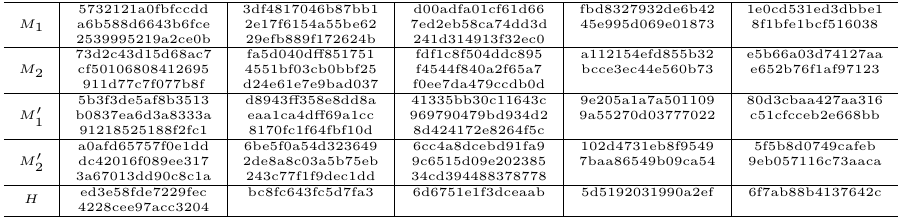
Table 6: Semi-free 4-bit Internal Collision Messages and Hash Value.